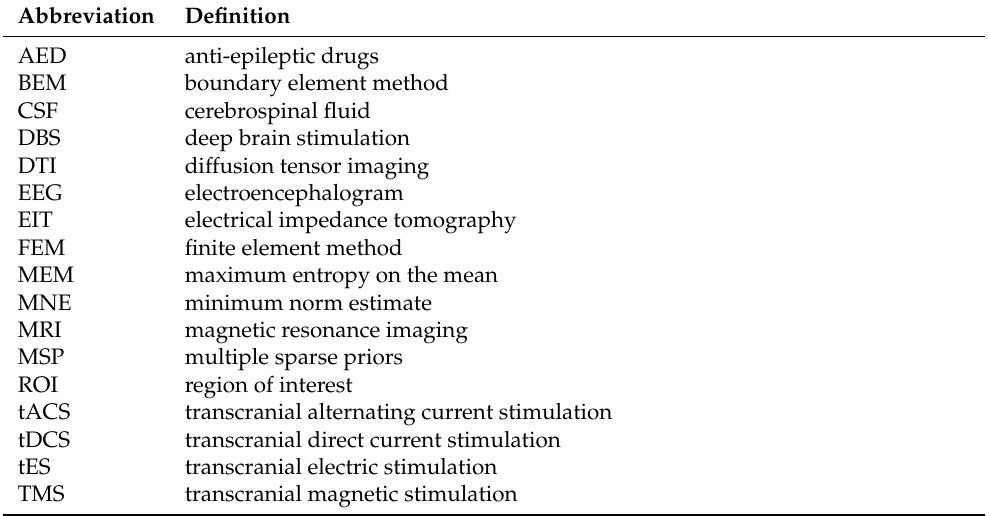
Table 1. List of abbreviations